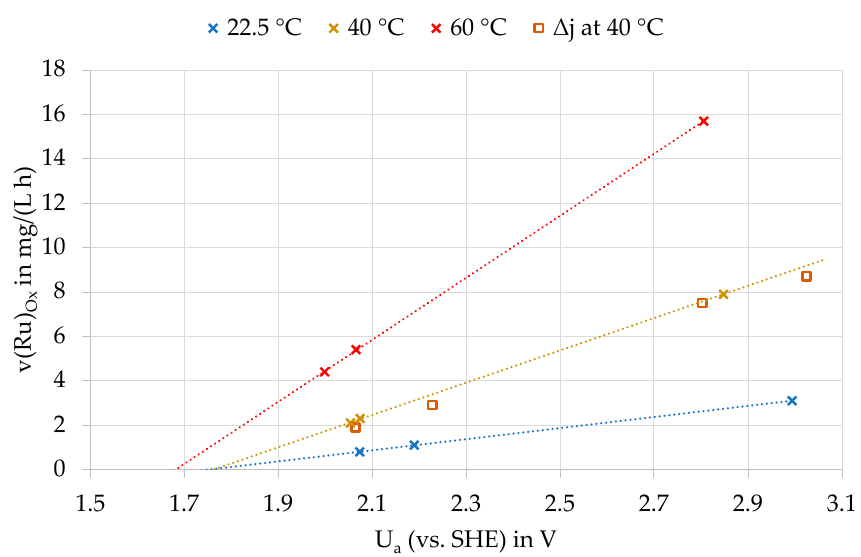
Figure 6. Oxidation rate of ruthenium (v(Ru) Ox ) as a function of anodic potential (U a ) and electrolyte temperatures; Δ j—variation of the current density with different anode materials at 40 °C.